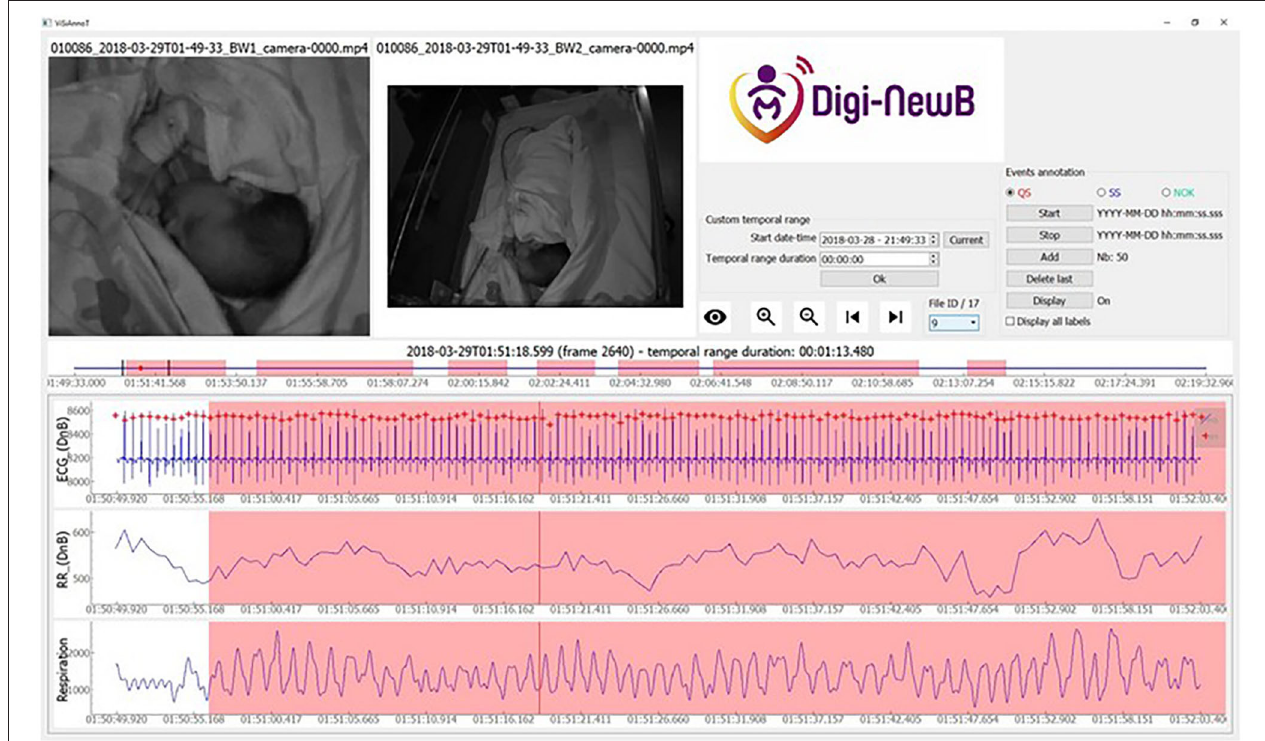
FIGURE 1 | Screenshot of ViSiAnnoT software displaying two videos and three signal plots, for a preterm infant at 35 + 5 days PMA. We used ViSiAnnoT to display two synchronized videos and three signals (ECG, RR time series, and respiration). In the progress bar (between the videos and the signal plots) there are seven annotated quiet sleep (QS) intervals in the 30-min file. Annotated quiet sleep interval is highlighted in